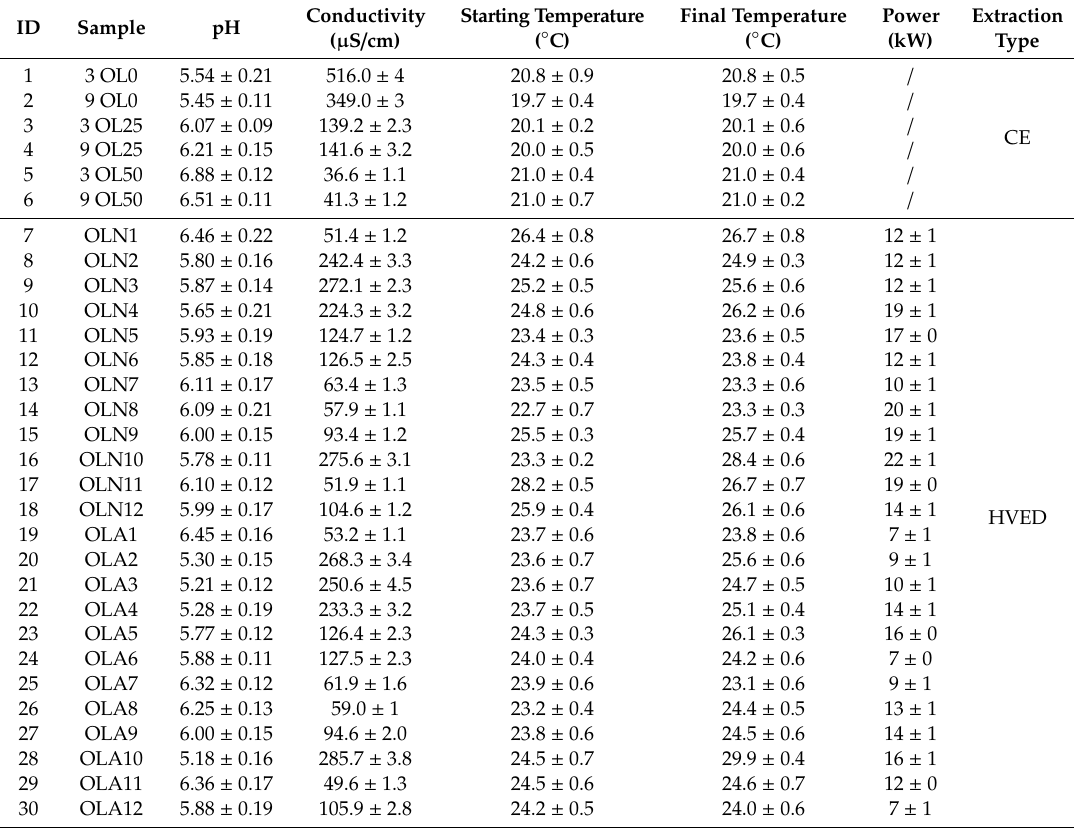
Table 2. Average values of pH, conductivity ( µ S / cm) for untreated and HVED treated samples, starting temperature ( ◦ C), final temperature ( ◦ C) and power (kW) after HVED treatments. ID